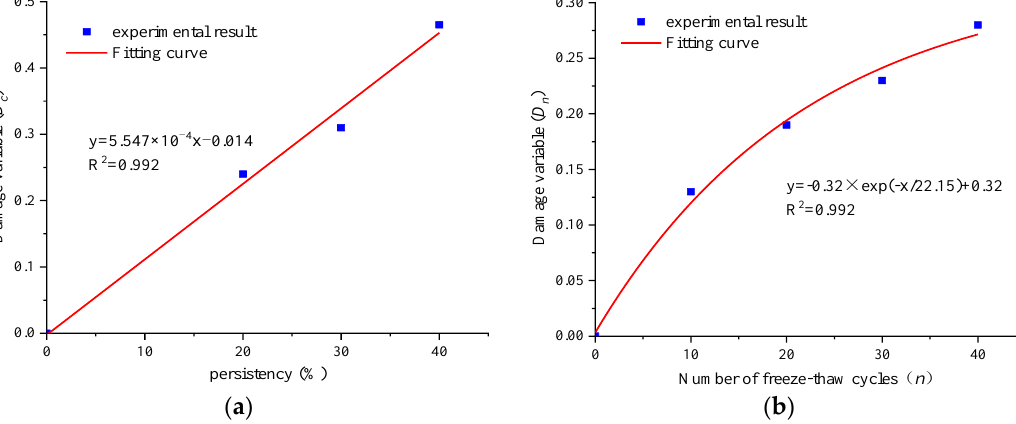
Figure 5. Damage evolution curve of ( a ) a jointed rock with persistency and ( b ) an intact rock with freeze–thaw cycles.